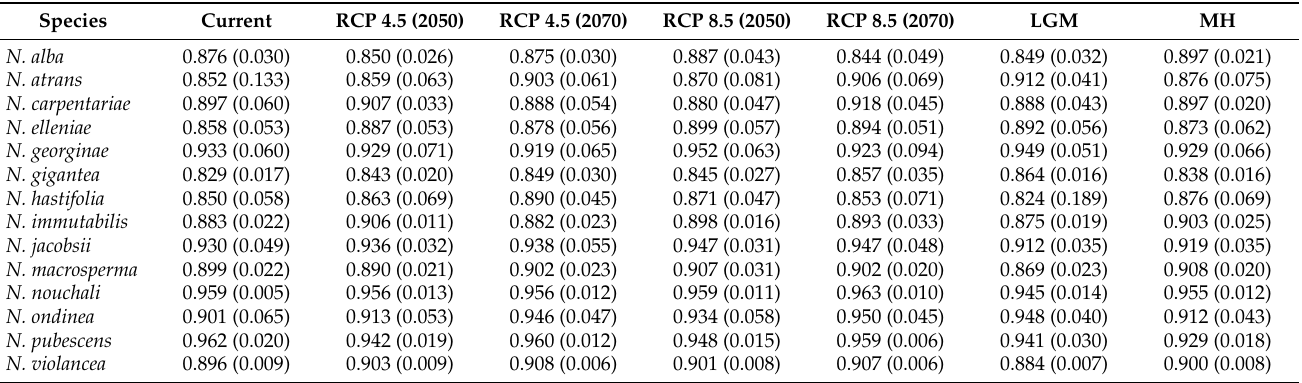
Table 3. The AUC values for training (75%) and test (25%) data for the Nymphaea species distribution suitability in Australia using the maximum training sensitivity plus specificity (MTSS) logistic threshold. In brackets: standard deviation